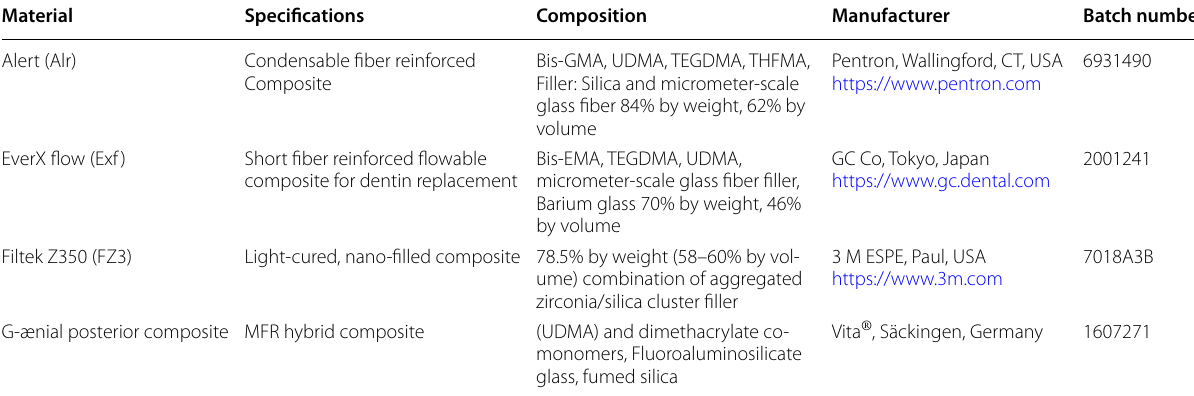
Table 1 Materials, compositions, and